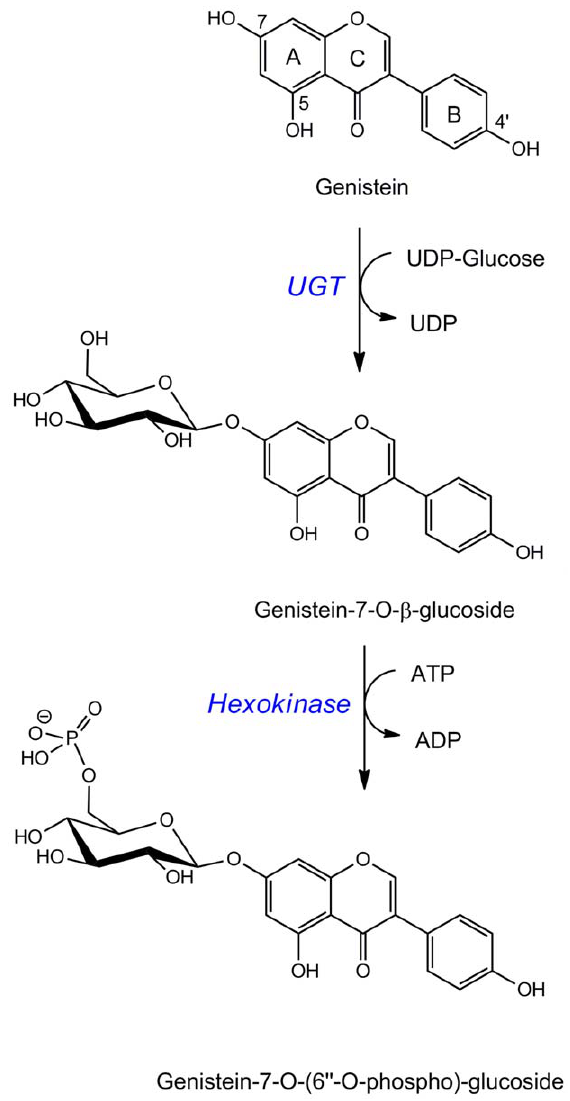
Figure 7. Proposed pathway for the conjugative metabolism of C.elegans leading to the main metabolites. UGT, UDP-glycosyl- transferase.